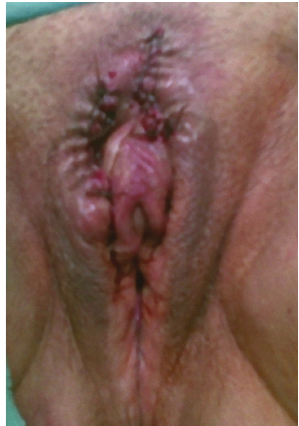
Figure 2: Postoperative view of the vulva.